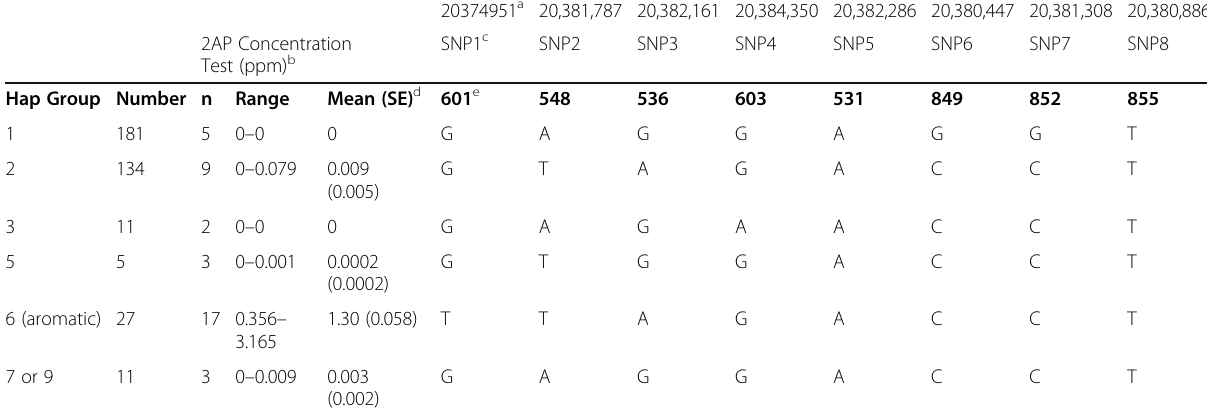
Table 2 Haplotype characterization and 2AP concentration across U.S. breeding germplasm panel